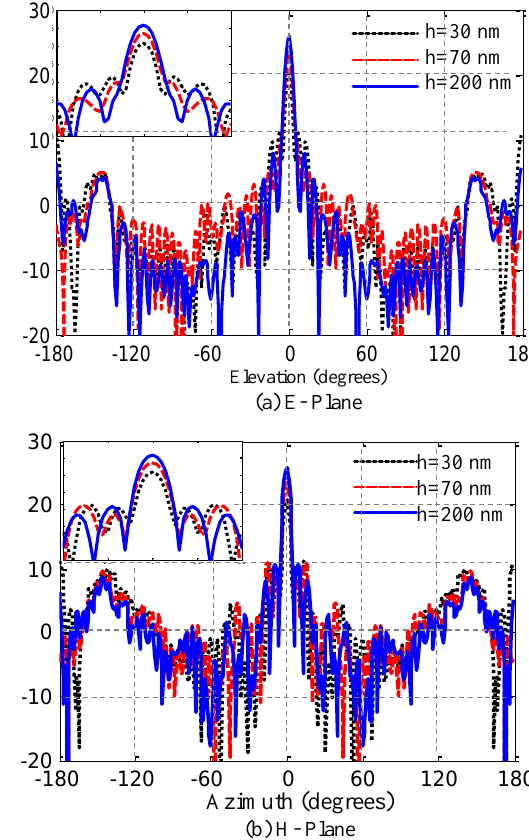
Figure 8 (a) The detailed structure of the NDRA reflectarray with silver supporting plane, (b) The phase shift distribution on the 21×21 unit-cell elements NDRA reflectarray with silver supporting plane.